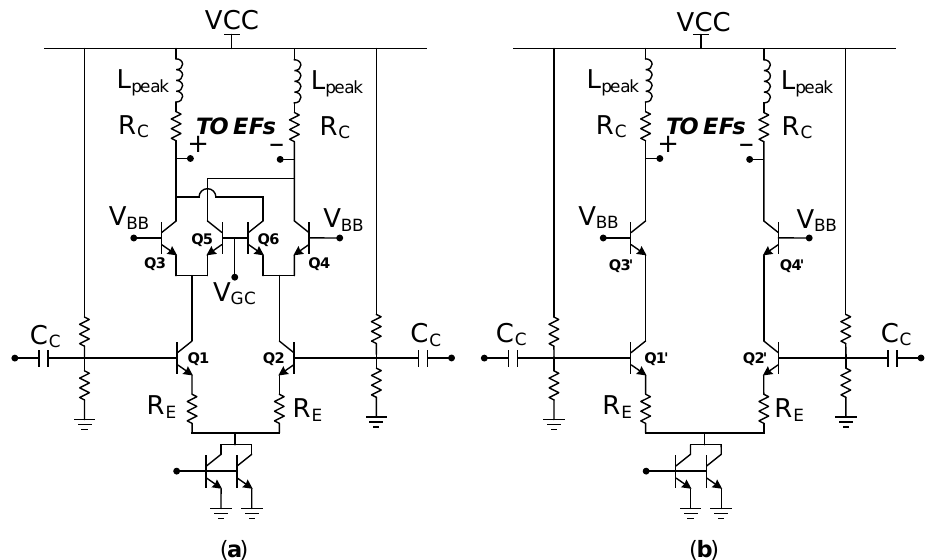
Figure 6. Schematic representation for: ( a ) Gilbert-cell-based VGA with emitter degeneration and shunt inductive peaking; ( b ) CGA formed by a cascode gain stage with emitter degeneration and shunt inductive